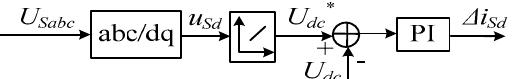
Figure 4. Voltage loop control diagram of APF with a droop controller in the d-q reference frame. From Figure 4, the output of the voltage outer loop PI controller is shown in Equation